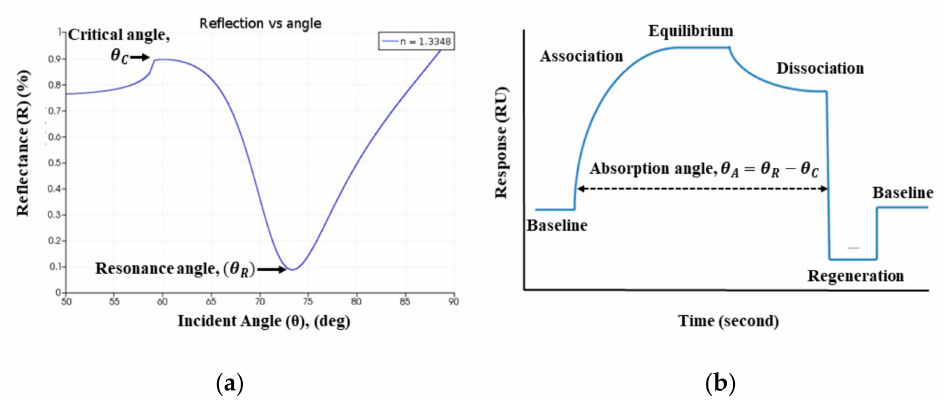
Figure 8. The Schematic of: ( a ) SPR, and ( b ) SPR sensorgram absorption